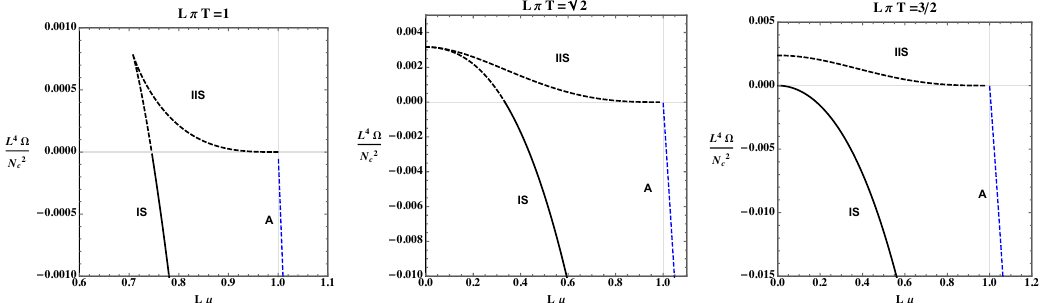
Figure 2 . Grand canonical potential as function of the chemical potential for di(cid:11)erent values of the temperature. Dashed lines correspond to unstable or metastable phases. The black curves are symmetric phases ( S ) and the blue curve is for the asymmetric phase ( A ). The symmetric branch with larger values of (cid:10) corresponds to the unstable phase ( IIS ), while the lower branch ( IS ) is metastable until it reaches (cid:10) = 0, which corresponds to the Hawking-Page transition. Susceptibilities diverge at the point where the two symmetric branches touch. At high enough temperatures, L(cid:25)T > 3 = 2, the Hawking-Page transition goes away and the stable symmetric phase dominates at low values of the chemical potential. In all cases, at large enough values of the chemical potential, the symmetric phase becomes unstable when the asymmetric phase becomes dominant. L(cid:25)T = 3 , and above this temperature the stable black hole phase is always dominant. In 2 (cid:12)gure 2, the blue curve corresponding to the asymmetric phase eventually crosses the solid curve and the symmetric phase becomes